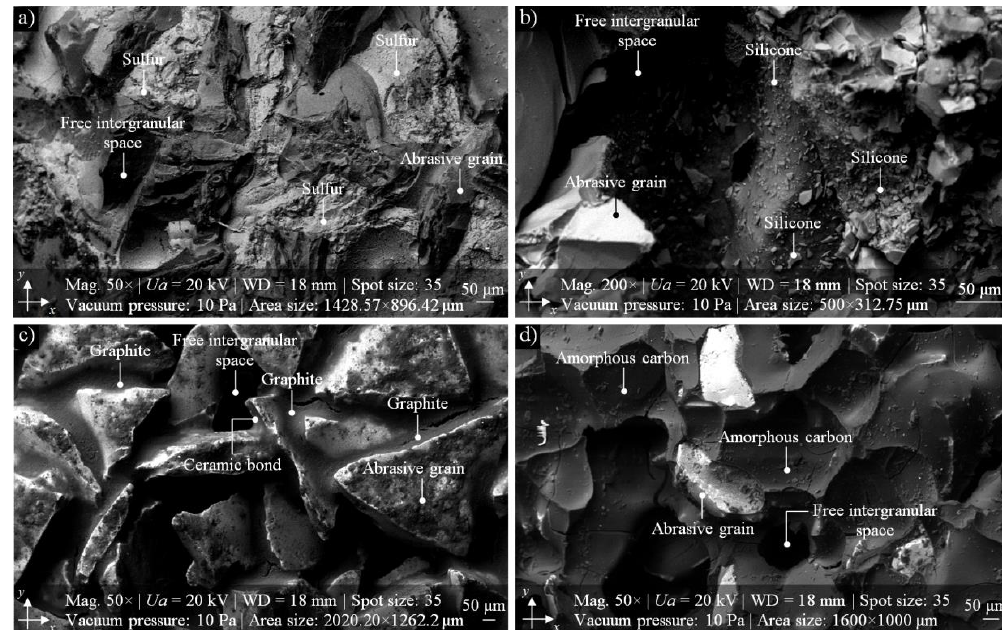
Figure 1. Collection of SEM micrographs obtained using a scanning electron microscope JEOL JSL-5500LV, presenting examples of the grinding wheel active surface (GWAS) impregnated with popular impregnating substances: ( a ) sulfur; ( b ) silicone; ( c ) graphite; ( d ) amorphous carbon [43, 44]. The most popular grinding wheels impregnated with sulfur or wax have the following major